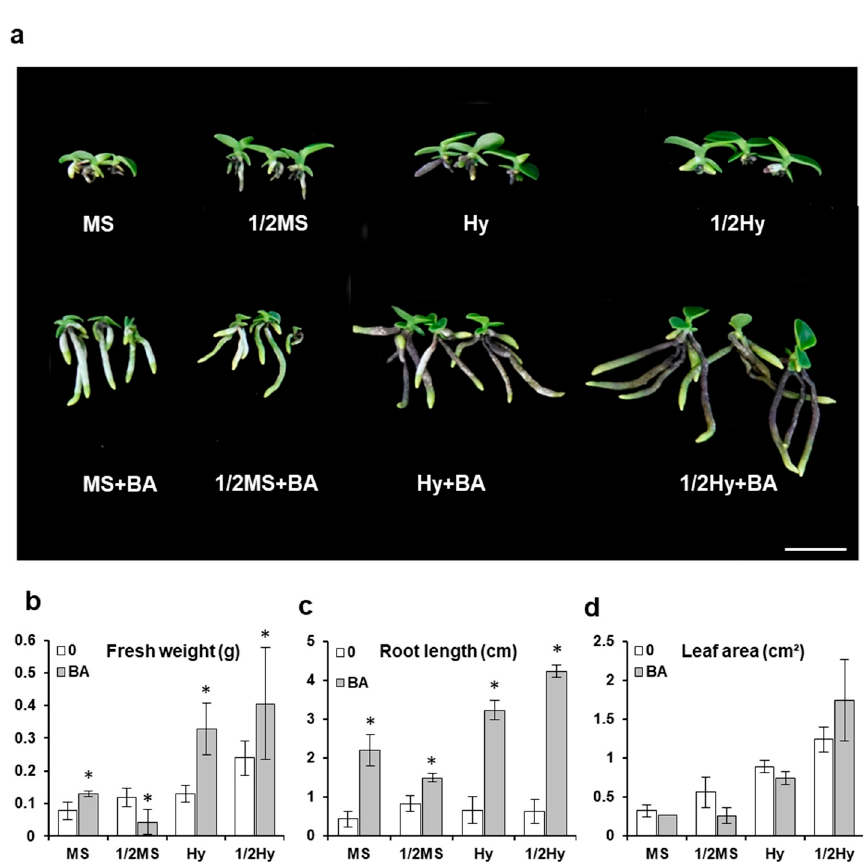
Figure 4. Effect of banana and apple homogenate (BA) on Sedirea japonica seedling growth. ( a ) Growth differences in seedlings were determined seven months after sowing. The pictures show a representative seedling of each medium. Fresh weight ( b ), root length ( c ), and leaf area ( d ) were measured. Scale bar = 2 cm. MS: full-strength MS; 1/2MS: half-strength MS; Hy: full-strength Hyponex; 1/2Hy: half-strength Hyponex. Data are shown as mean ± SD of the values obtained from triplicate experiments. * p ≤ 0.05.